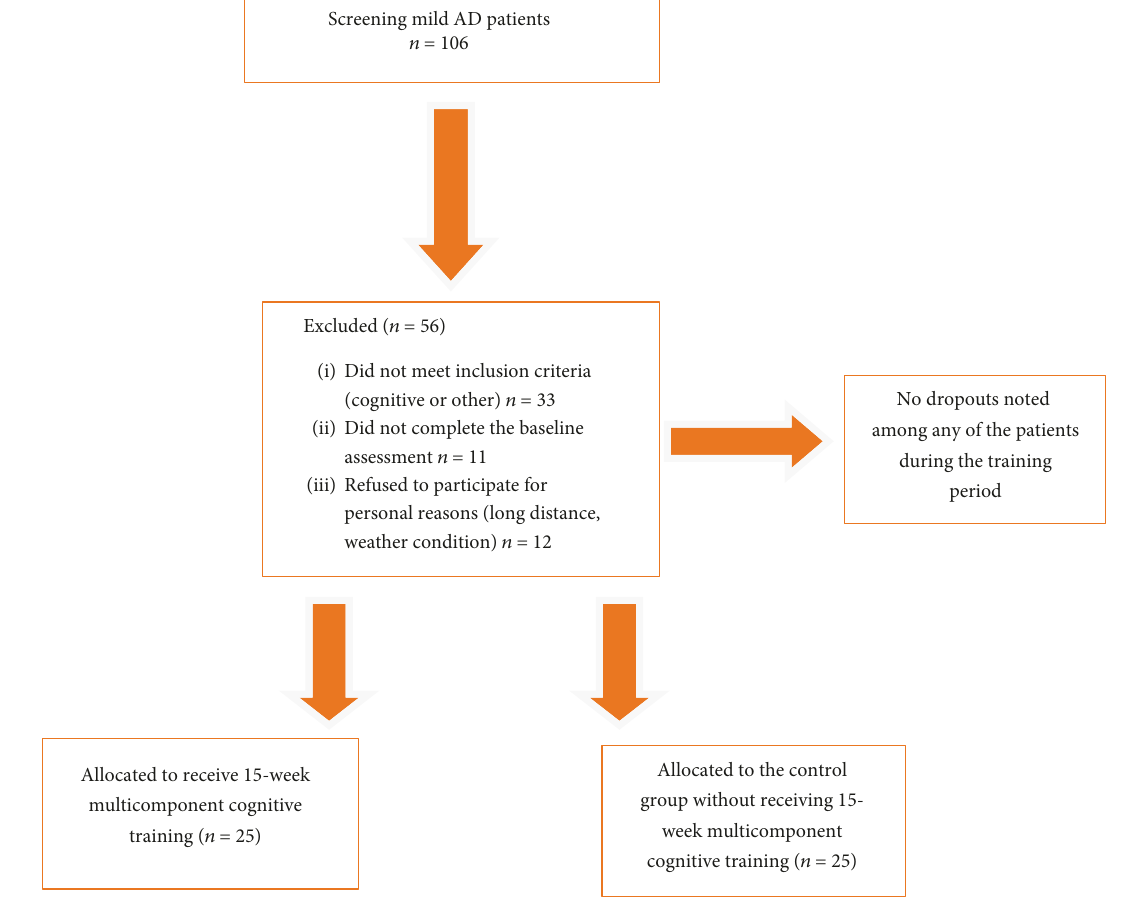
Figure 1: Participants ’ fl ow diagram. Table 1: Demographic and clinical characteristics of the training and control groups at